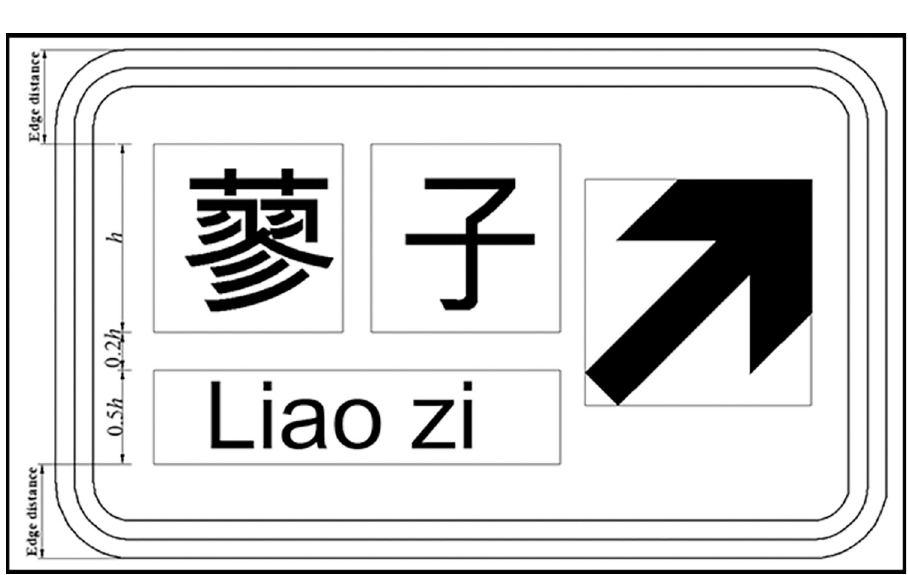
Fig 5. Layout of single row text with English place name type exit advance guide sign.